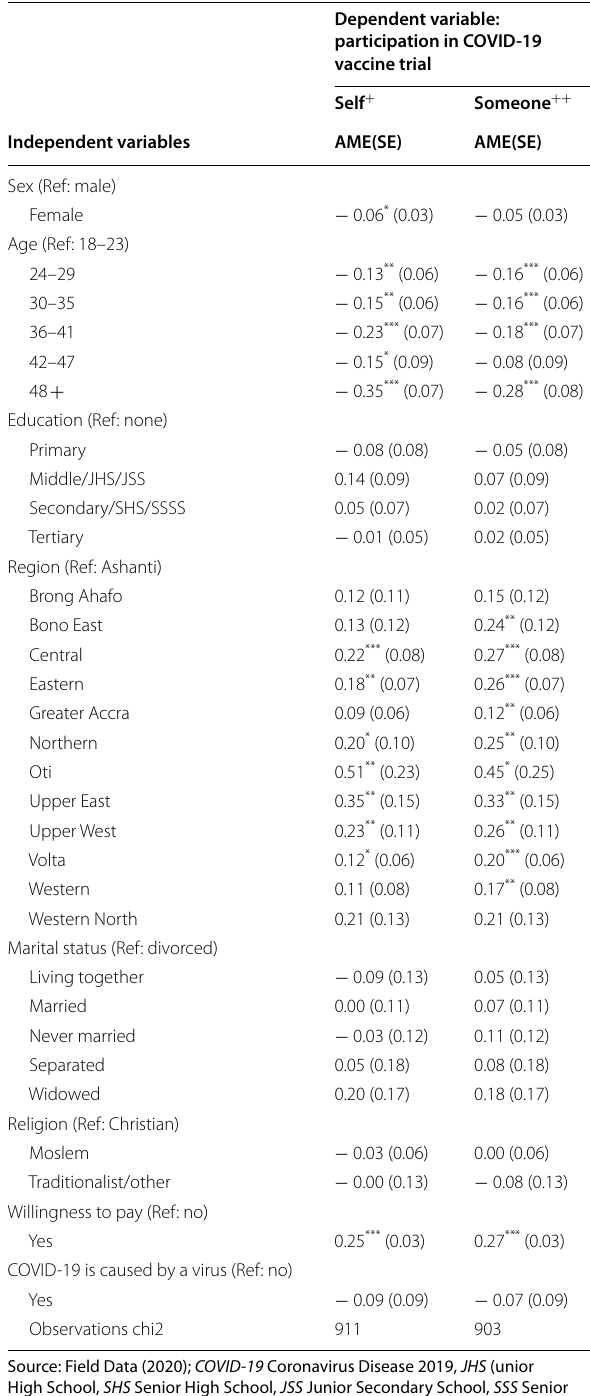
Table 2 Probit regression estimates of determinants of willingness to participate in COVID‑19 vaccine